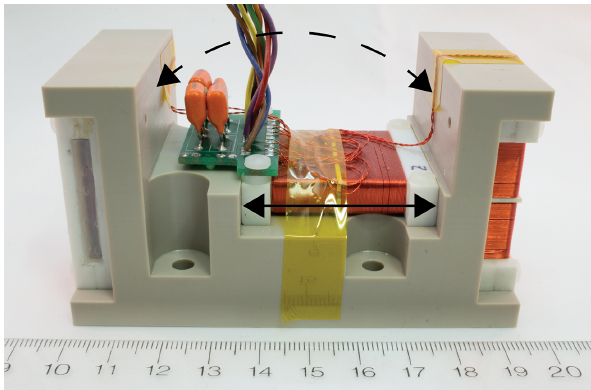
Figure 17. MACOR/PEEK sensor showing the asymmetry in PEEK material above and below the centre MACOR bobbin. Mismatch in thermal expansion between the centre bobbin (solid arrow) and the base could potentially force the two outer bobbins to skew away from orthogonal (dashed arrow) as the sensor changes